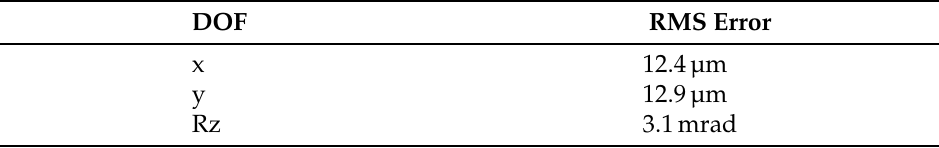
Figure 27. The steady state error during control of the wafer in x and y. Table 5. Wafer position control-steady state